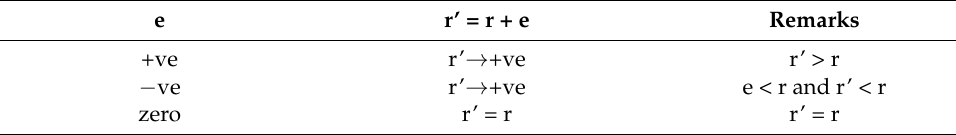
Table 6. Mathematical representation of set-point